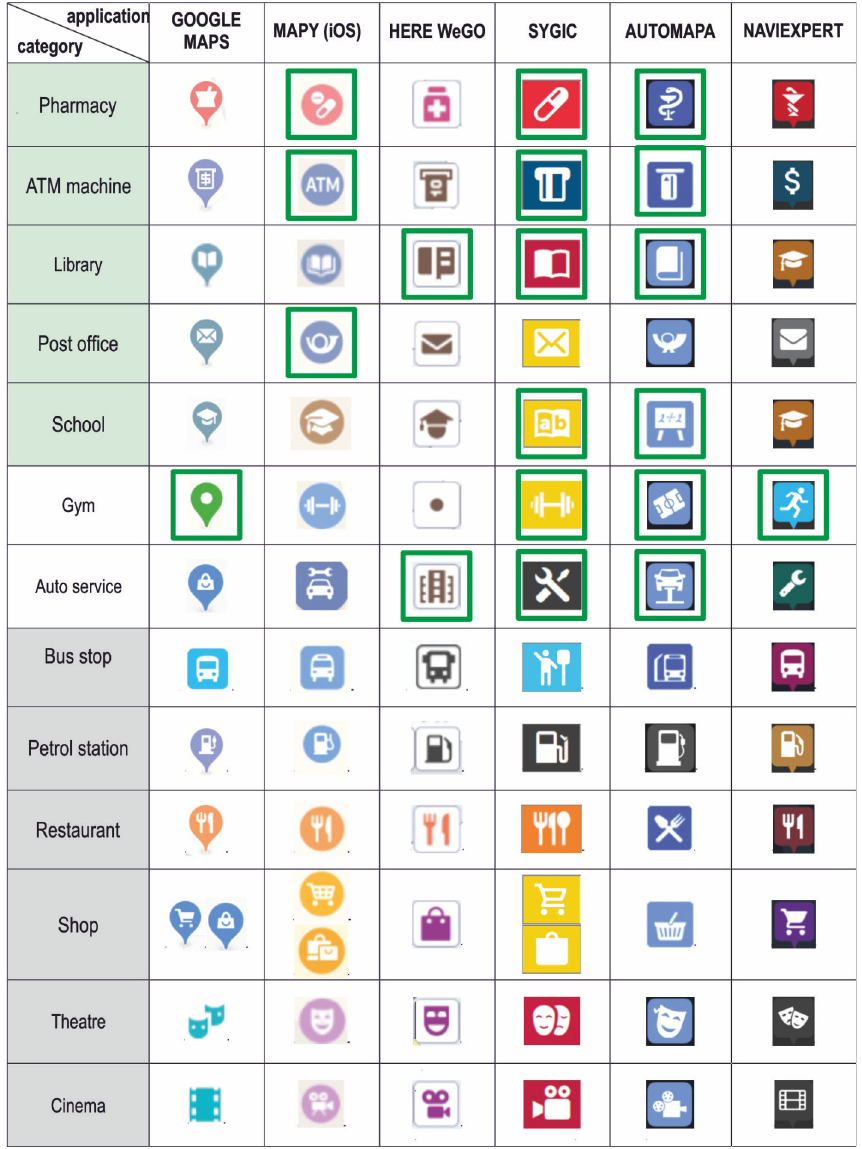
Table 2. Symbols from the selected